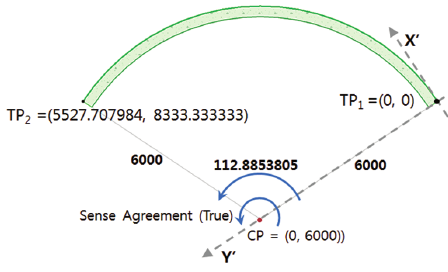
Fig. 12. Points extracted from model A